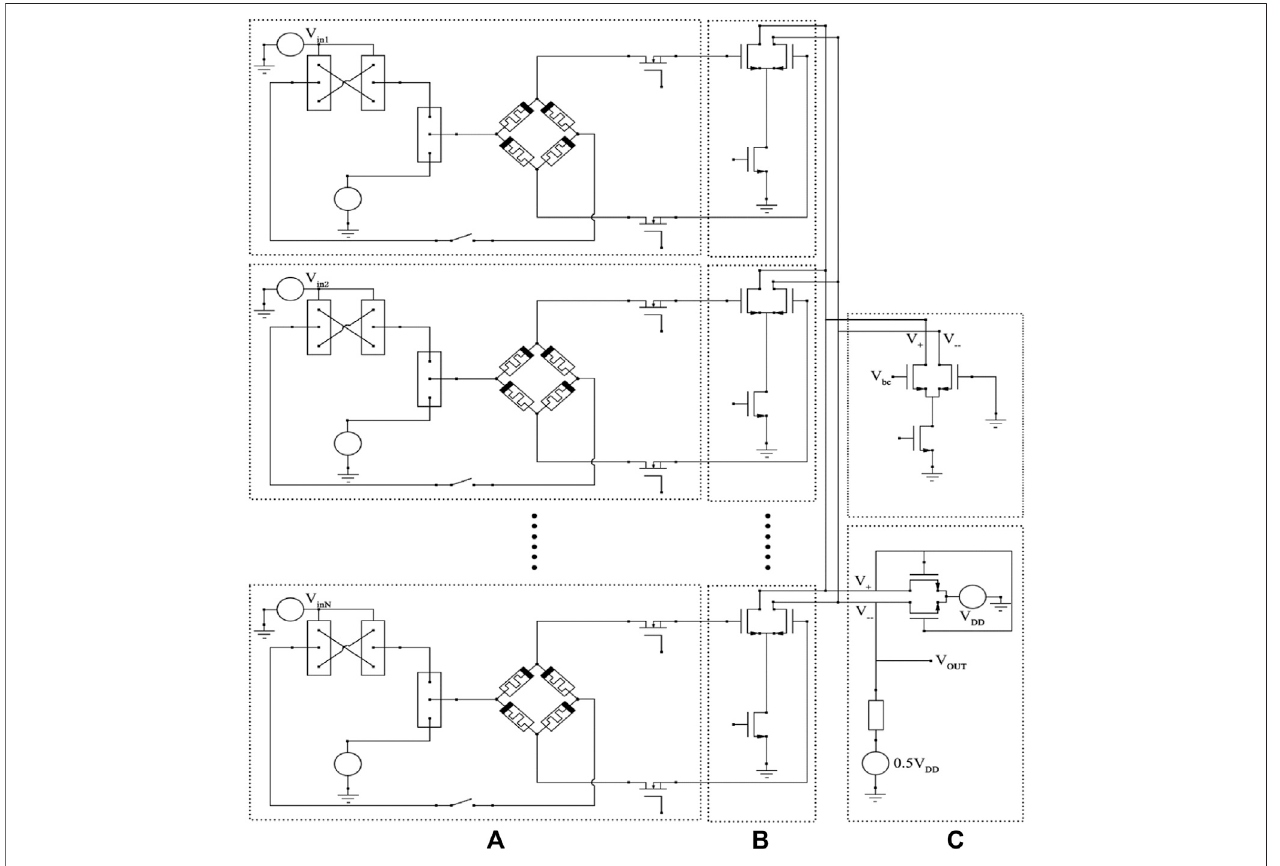
FIGURE9| Dual-modememristivebridgesynapticneuralnetwork. (A) Dual-modememristivebridgesynapticcircuit. (B) Differentialpaircircuit. (C) Effectiveloadcircuit.